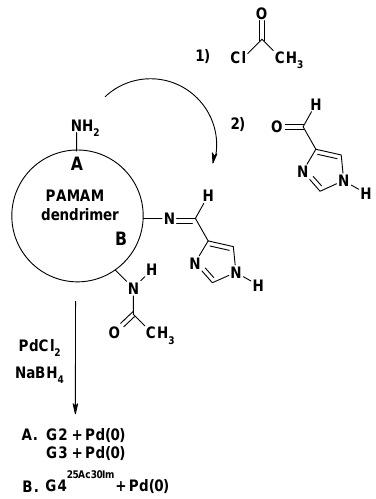
Figure 2. Schematic representation of synthesis of PAMAM dendrimer supported catalysts.